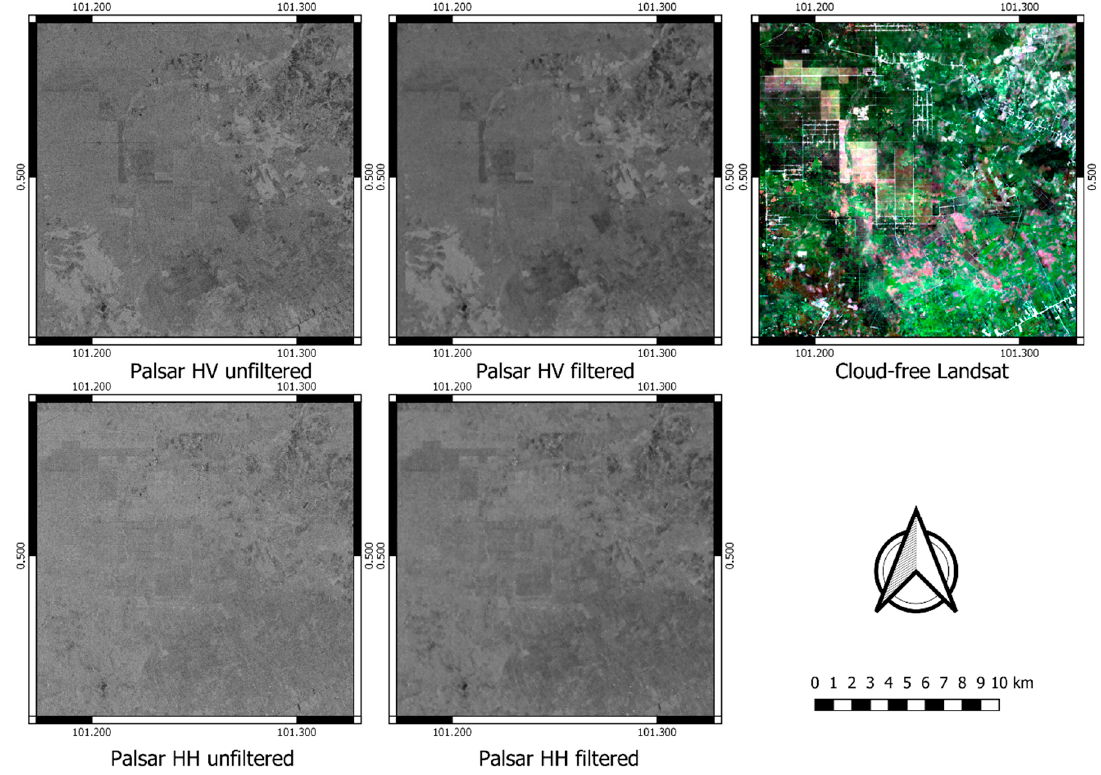
Figure 2. Results of image pre-processing for synthetic aperture radar (SAR) and Landsat imagery taken from the regency of Kampar, Riau province, 101°25’00” E 0.50°00’00” N.